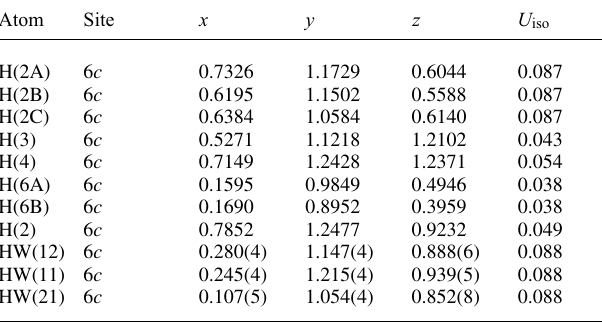
Table 2. Atomic coordinates and displacement parameters (in Å 2 )